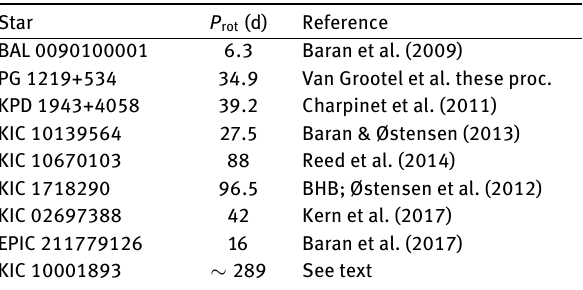
Table 2. List of single pulsating sdB stars with a rotation period estimated from asteroseismology.